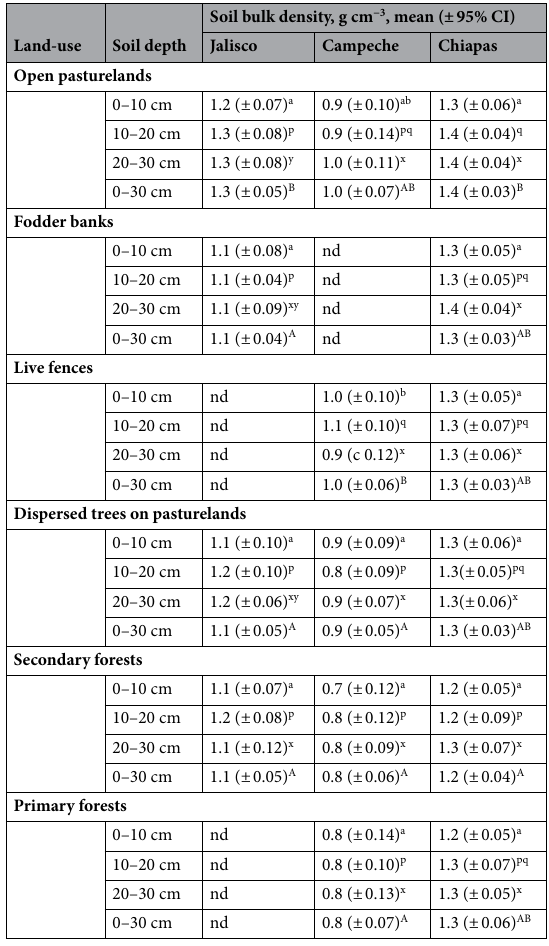
Table 5. Soil bulk density (g cm −3 ) across land-uses by depth category and study region. Different letters indicate the statistical differences between land-uses (p < 0.05). CI = Confidence intervals. nd: data not